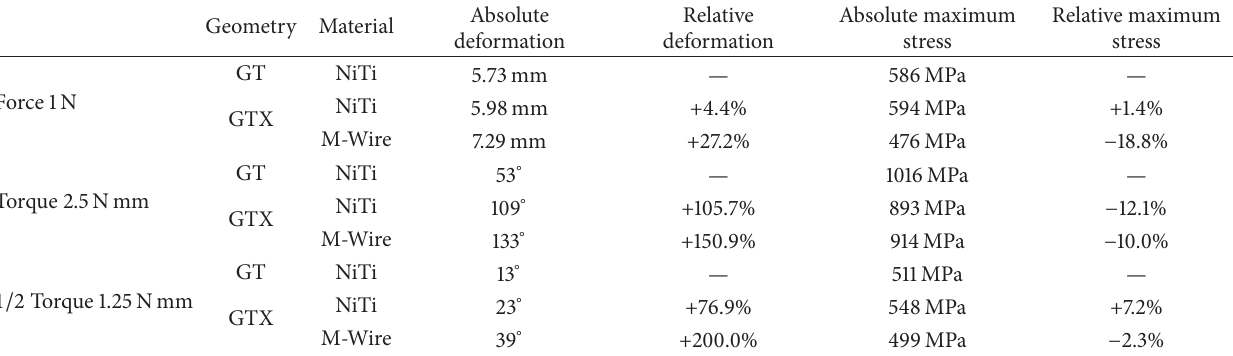
Table 1: Summary of the Finite Element modelling results (GT file’s results were used as reference for the relative deformations and stresses). Geometry